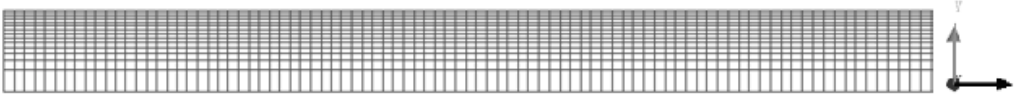
Figure 2. The two-dimensional mesh of the tubular-membrane longitudinal section.